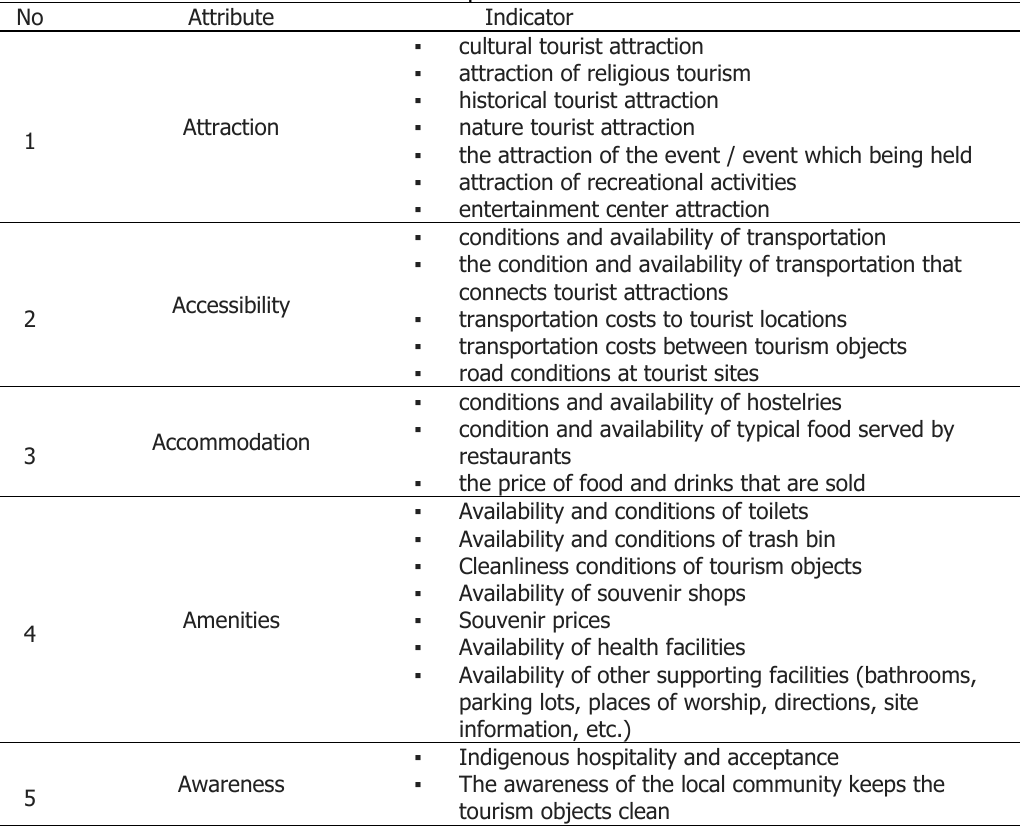
Table 1. Operational